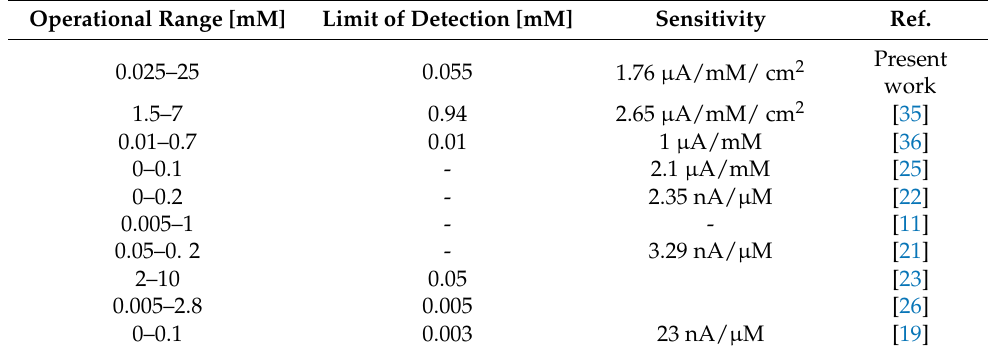
Table 2. Comparison of present work to other amperometric glucose